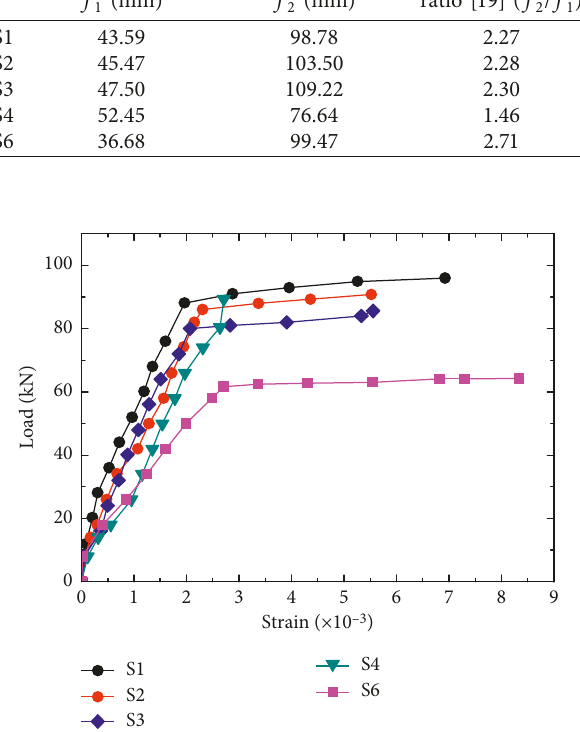
Figure 9: Load-strain curves of the tensile steel